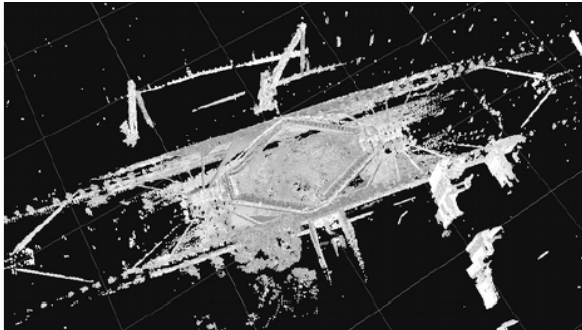
Figure 6 . Underground railway station point cloud (partial) – February 2021 survey.